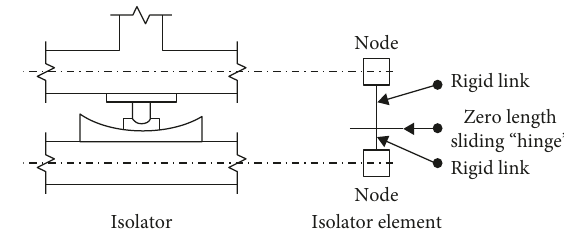
Figure 9: Friction pendulum